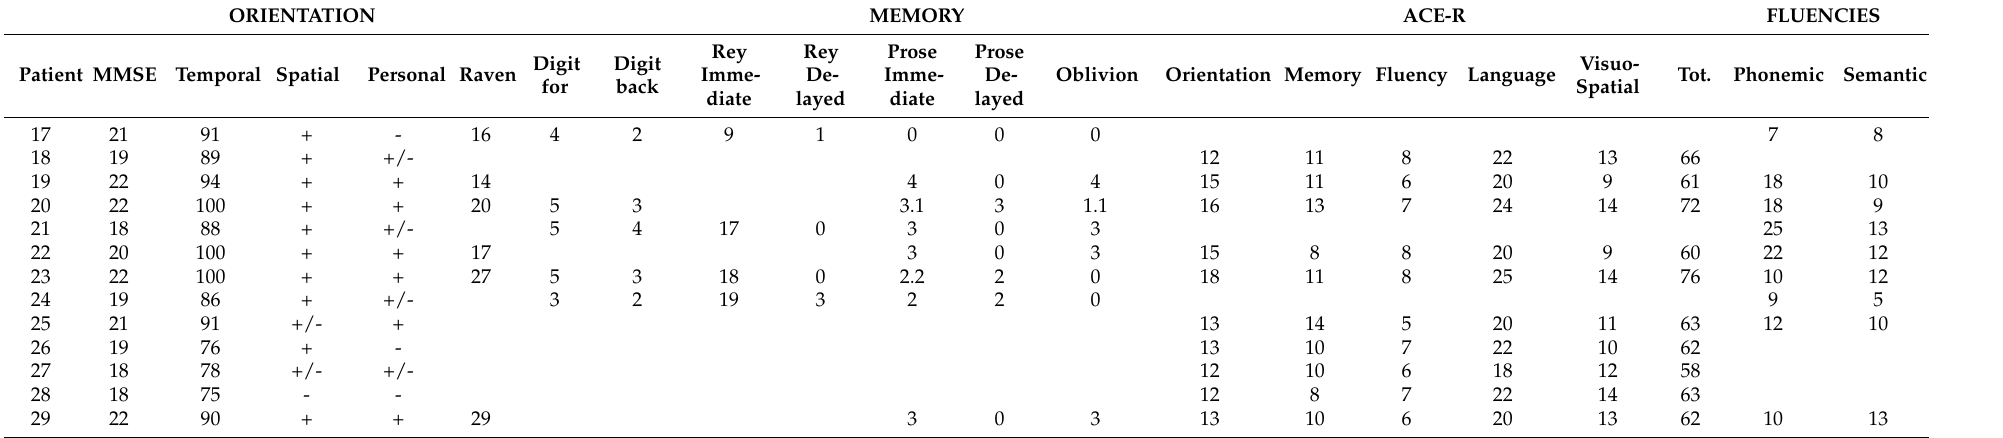
Table 3. Neuropsychological tests’ scores in VD-type